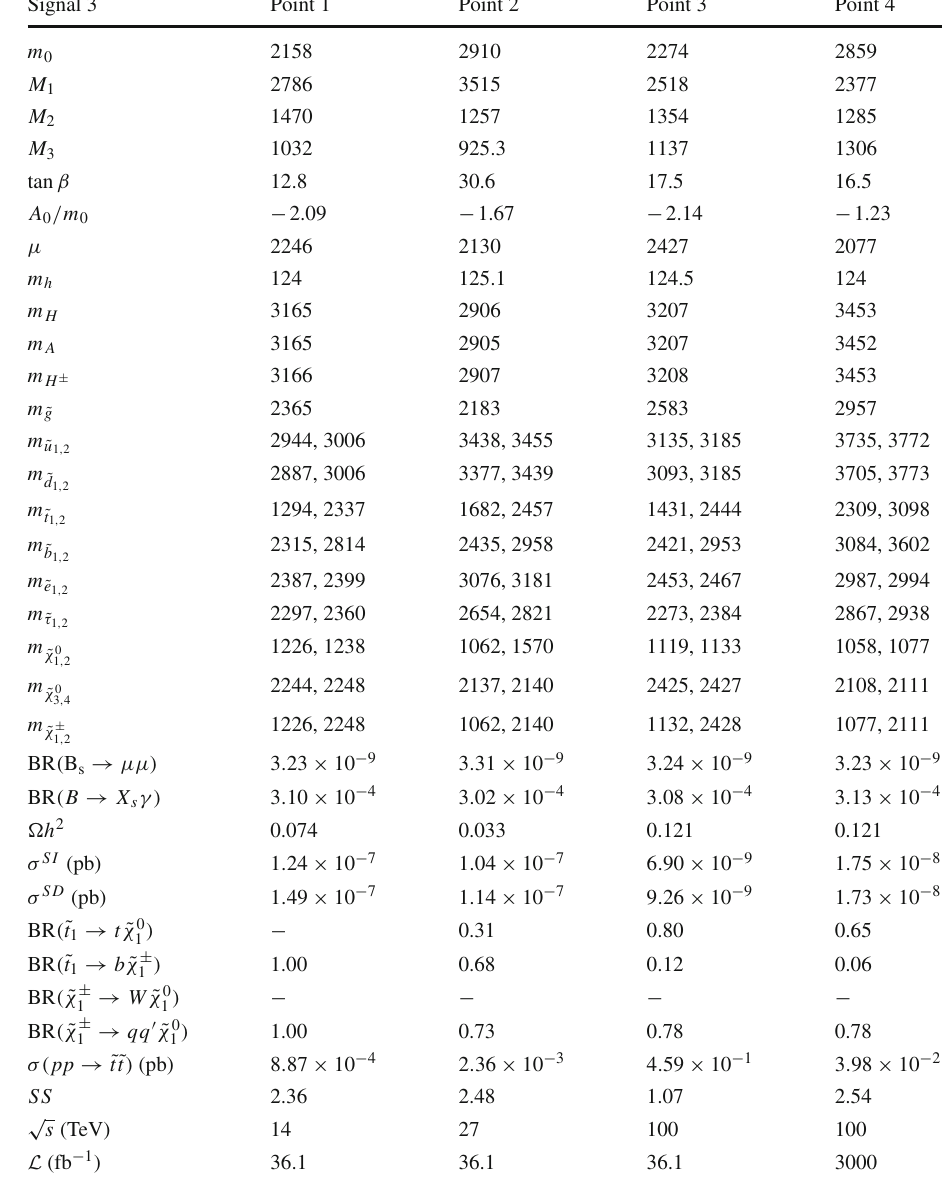
Table 3 Benchmark points of stop probes within 68% and 95% CL through Signal 3. The point selection is the same as explained in Table